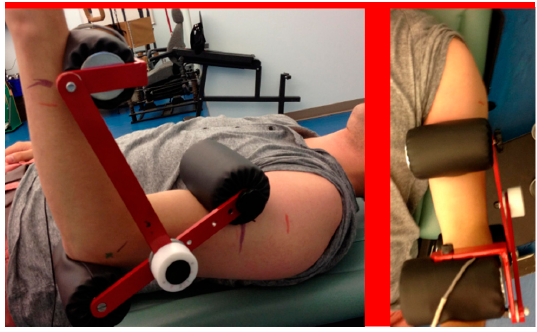
Figure 4. Testing set-up of LSMD in flexion ( left ) and extension ( right ).